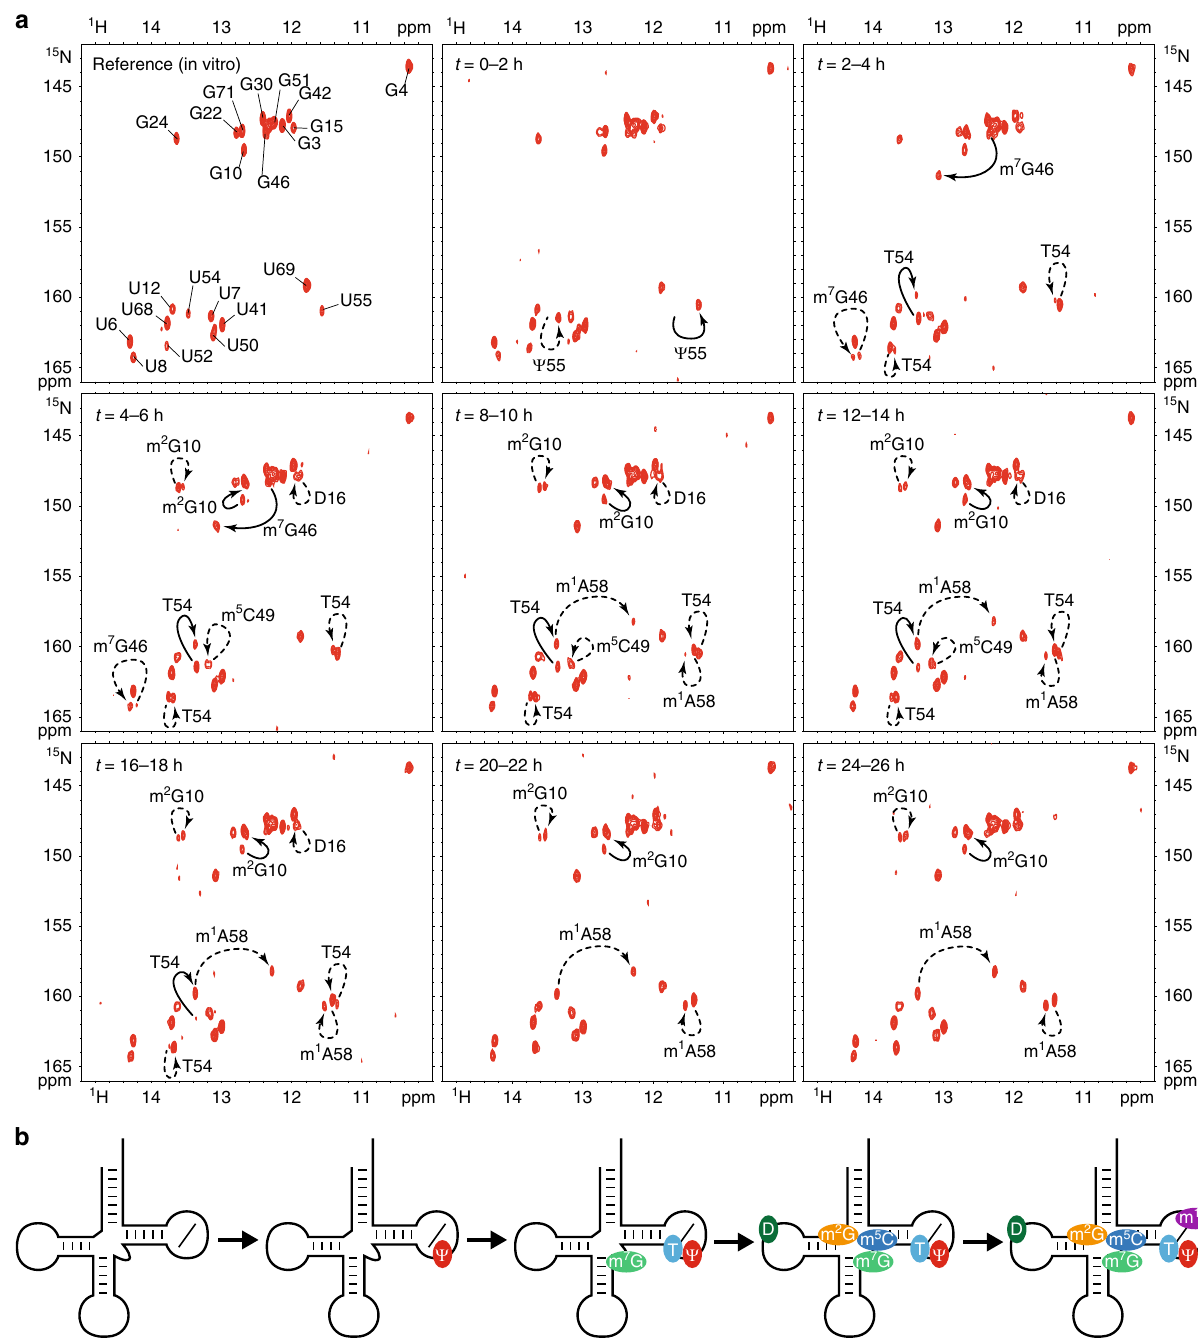
Fig. 4 Time-resolved NMR monitoring of RNA modi fi cations in yeast tRNA Phe . a Imino ( 1 H, 15 N) correlation spectra of a 15 N-labeled tRNA Phe measured in vitro ( fi rst top left spectrum — same as Fig. 2b left) and in a time-resolved fashion during a continuous incubation at 30 °C in yeast extract over 26 h (remaining eight spectra). Each NMR spectrum measurement spreads over a 2 h time period, as indicated. Modi fi cations detected at the different steps are reported with continuous line arrows for direct effects, or dashed arrows for indirect effects (see main text for the distinction between direct and indirect effects). b Schematic view of the sequential order of the introduction of modi fi cations in yeast tRNA Phe as observed with NMR. Each modi fi cation is associated with a de fi ned color also used in Figs. 5 and